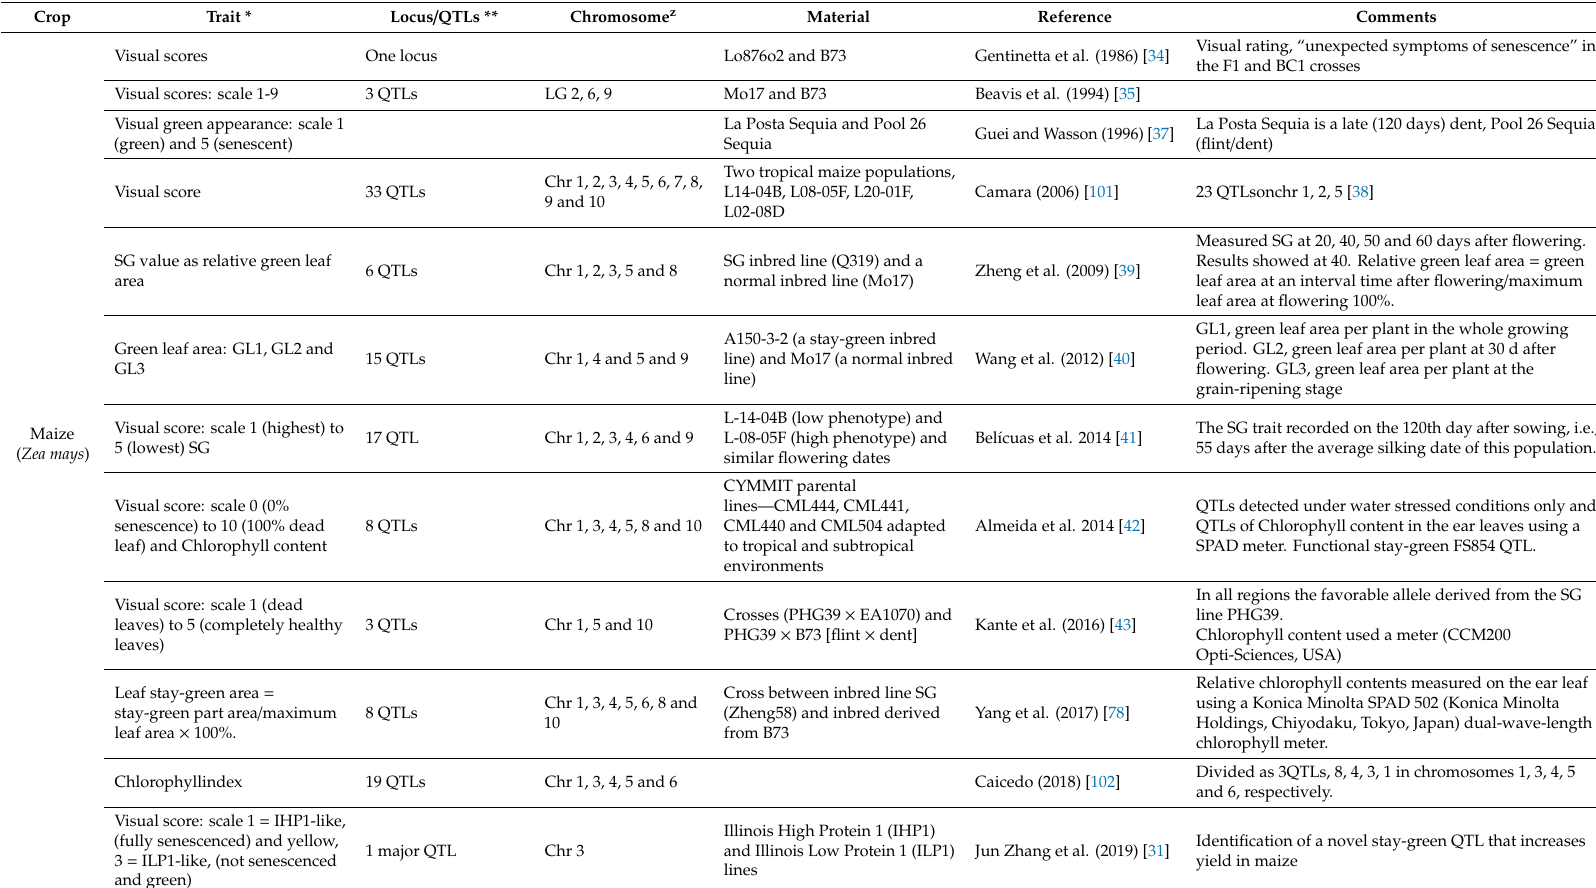
Table 2. Genetics of stay-green: trait scoring method, number of quantitative trait loci (QTLs), germplasm used and reference for maize and rice crops. Crop Trait * Locus / QTLs ** Chromosome z Material Reference Comments